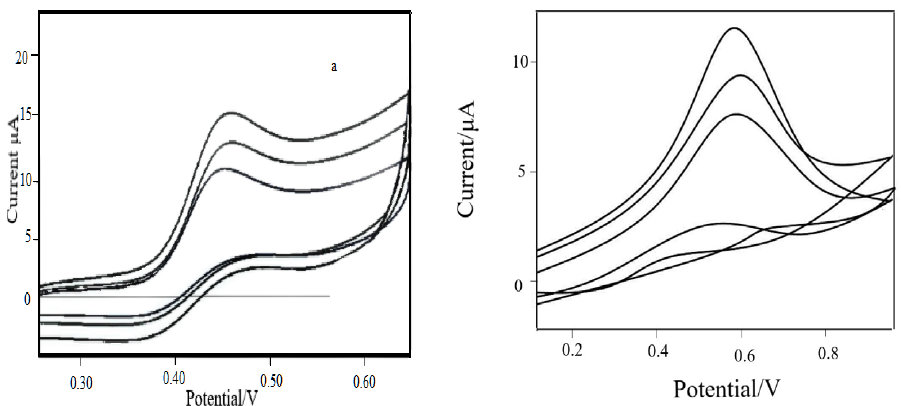
Fig. 5.a. Cyclic voltammogram recorded on CuO NPs – rGO / GCE electrode Vs Ag/AgCl, Sat KCl in presence of 0.1M KCl at scan rates 20, 50, 100 m Vs -1 , at 25°C for 2.0 m M Ponceau 4R dye and (b). Alizarin red